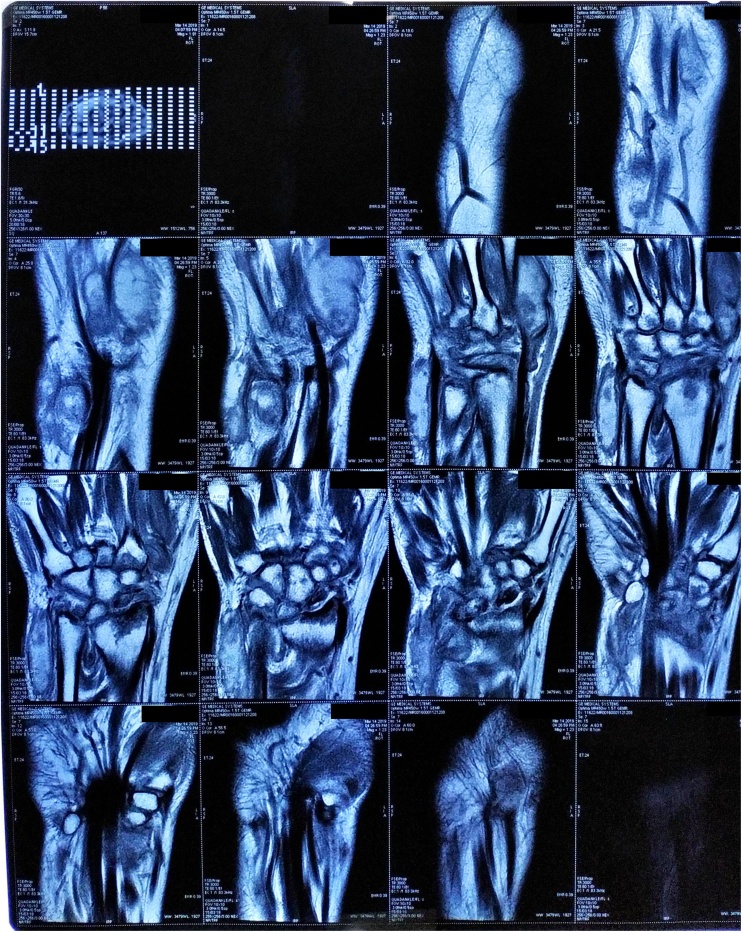
MRI of the wrist.